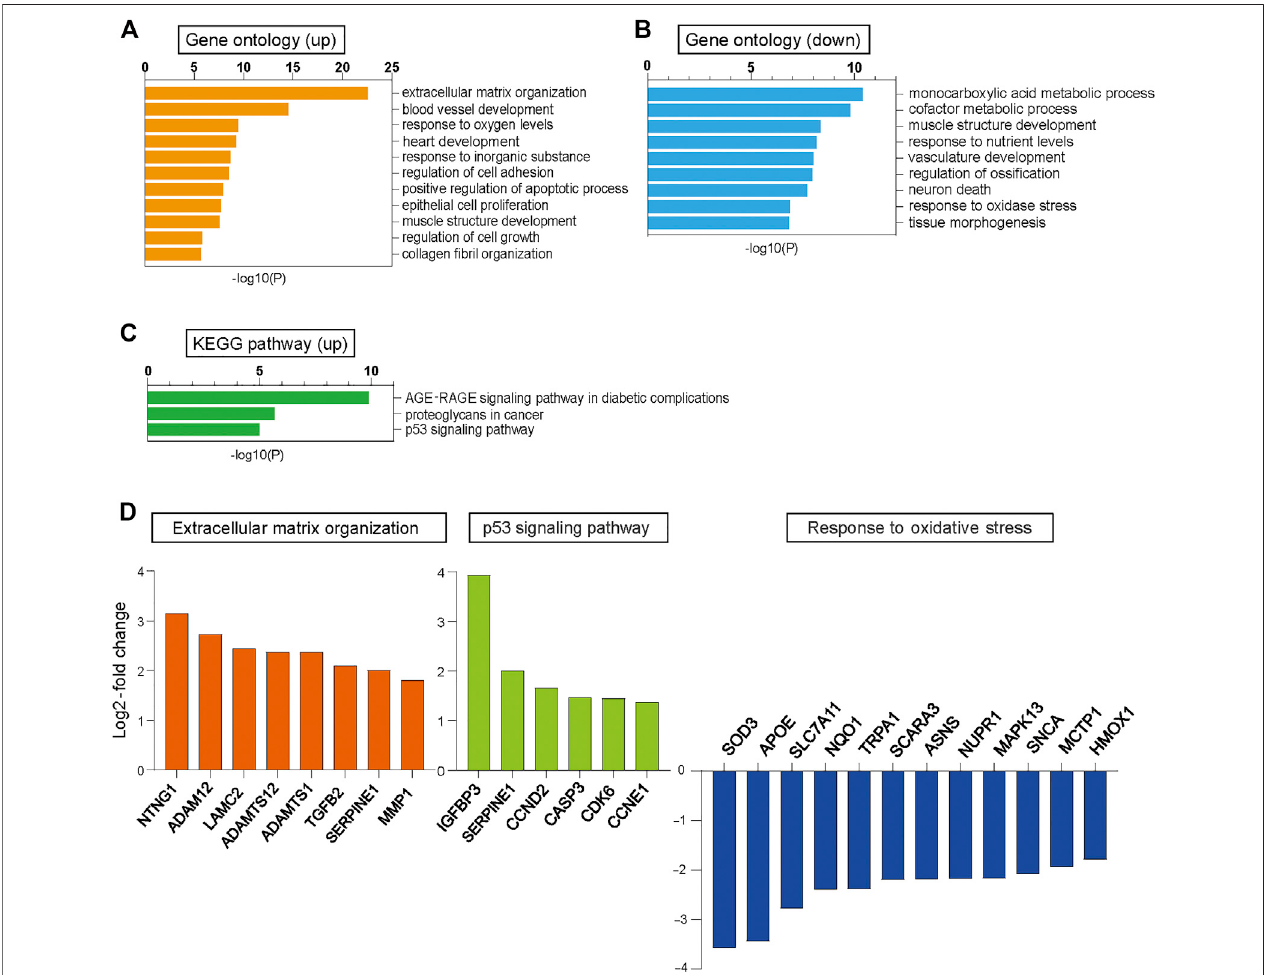
FIGURE2 | RNA-seq analysis in CUG exp − and CUG exp+ cells. (A) Bar graphsdisplayingthe GO categories showing signi fi cant enrichment among the upregulated genes in cells expressing CUG exp (CUG exp+ ) at day 51. (B) Bar graphs displaying the GO categories showing signi fi cant enrichment among the downregulated genes in CUG exp+ cells at day 51. (C) Bar graphs displaying the Kyoto Encyclopedia of Genes and Genomes (KEGG) pathways showing signi fi cant enrichment for upregulated genes in CUG exp+ cells. (D) Expression levels of representative upregulated or downregulated genes in CUG exp+ cells involved in ECM organization (orange), p53 signaling pathway (green), and response to oxidative stress